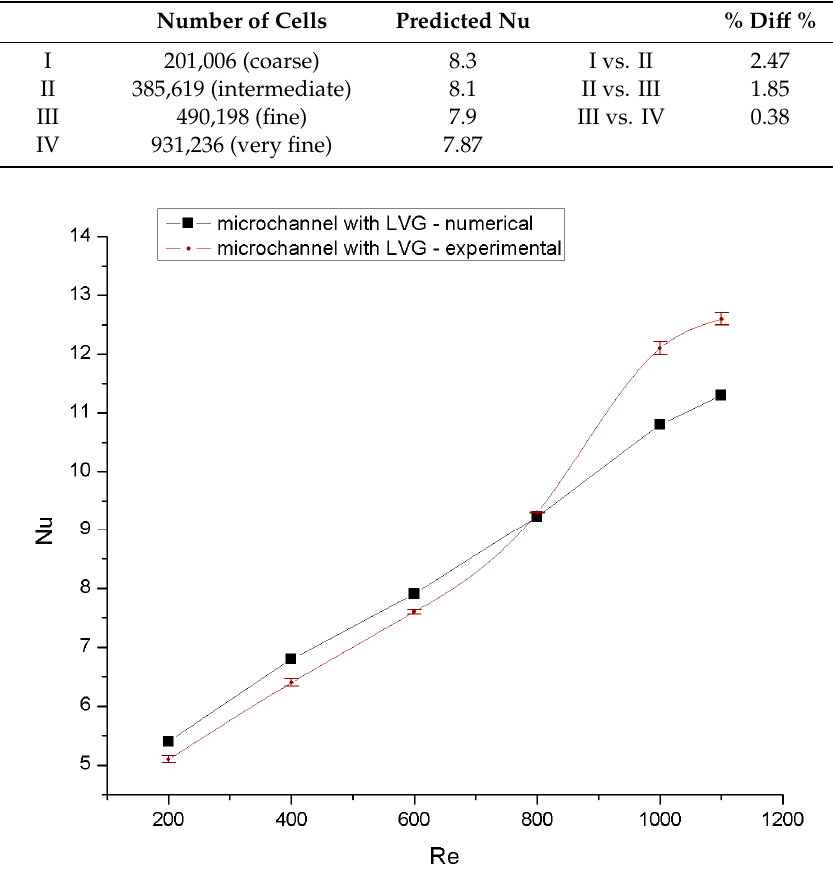
Figure 4. Comparison of Nu number values from the present numerical simulation and the experimental results of Liu et al. [25] .